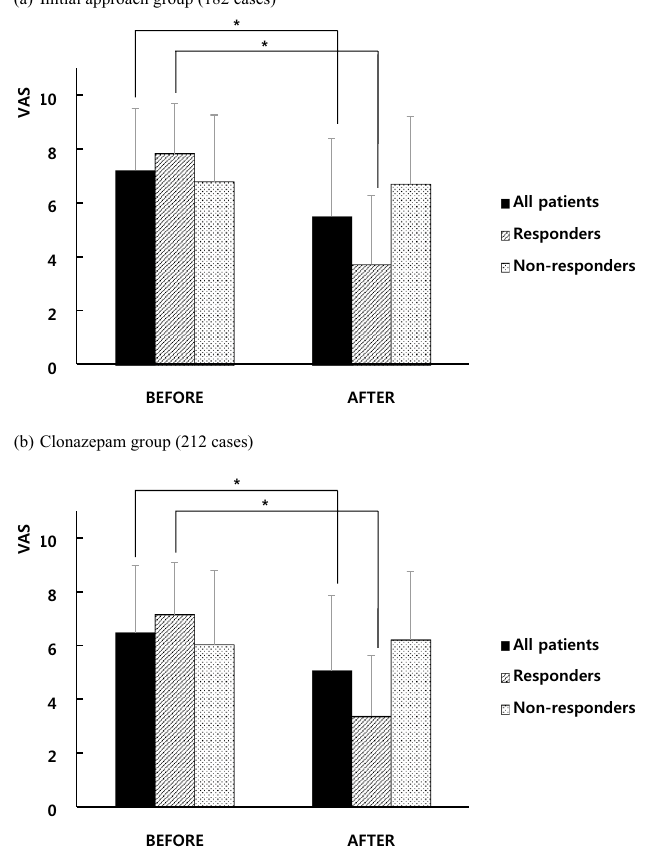
Figure 1. VAS scores of oral symptoms before and after ( a ) the initial approach and ( b ) clonazepam therapy. The error bars represent standard deviation (SD). VAS, visual analog scale. * P < 0.001.